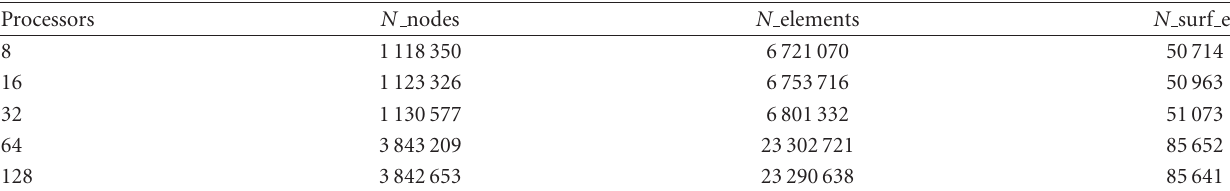
Table 2: Final grid sizes for di ff erent number of processors after 3 adaptation steps and after 1 adaptation step for 64 and 128 restarting from 32 final solution and grid. 3D wedge.